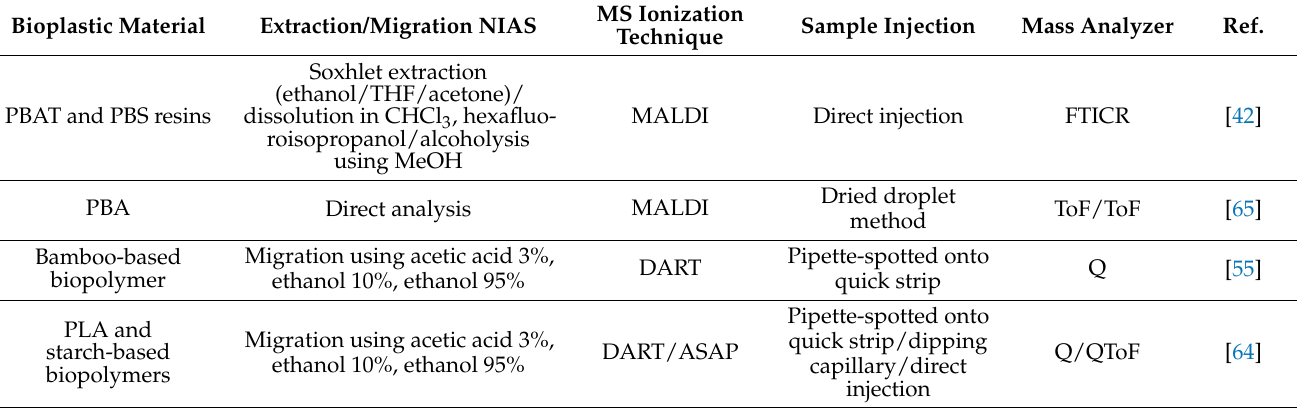
Table 4. MALDI and AMS methods for the investigation of NIAS in